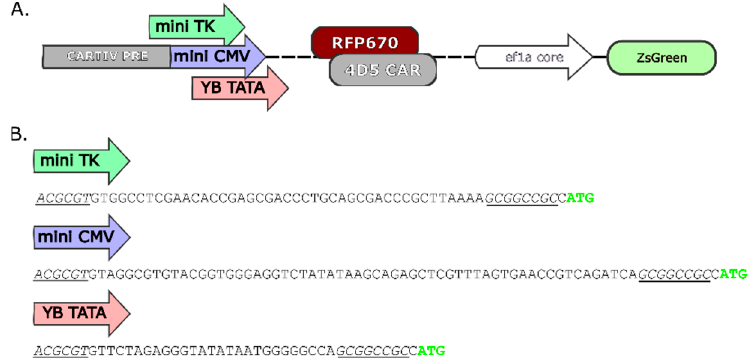
Figure 1. The different minimal promoters cupelled to the CARTIV promoter response element and the vectors used: ( A ) Schematics of the CARTIV synthetic promoters tested and the vector used. ( B ) Sequences of the three minimal promoters tested. In italic and underlined are the mluI and notI restriction sites, respectively, in light green the ATG start codon.